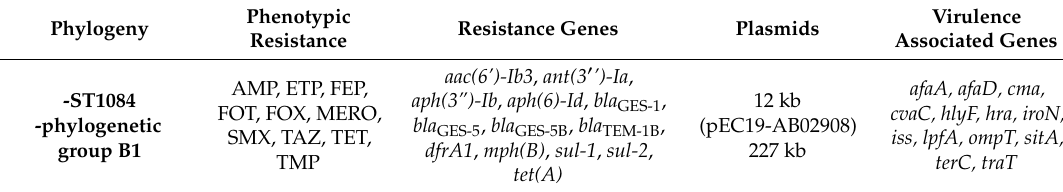
Table 1. Main characteristics of the GES-producing E. coli isolate 19-AB02908.